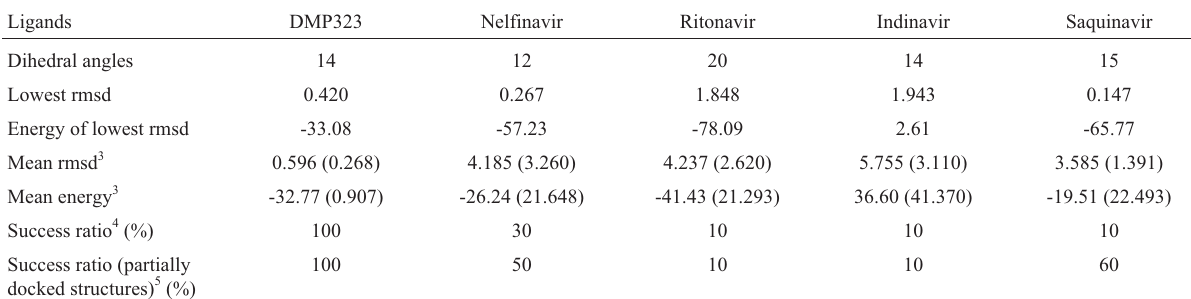
Table 3 - Flexible docking results using the Cauchy distribution.